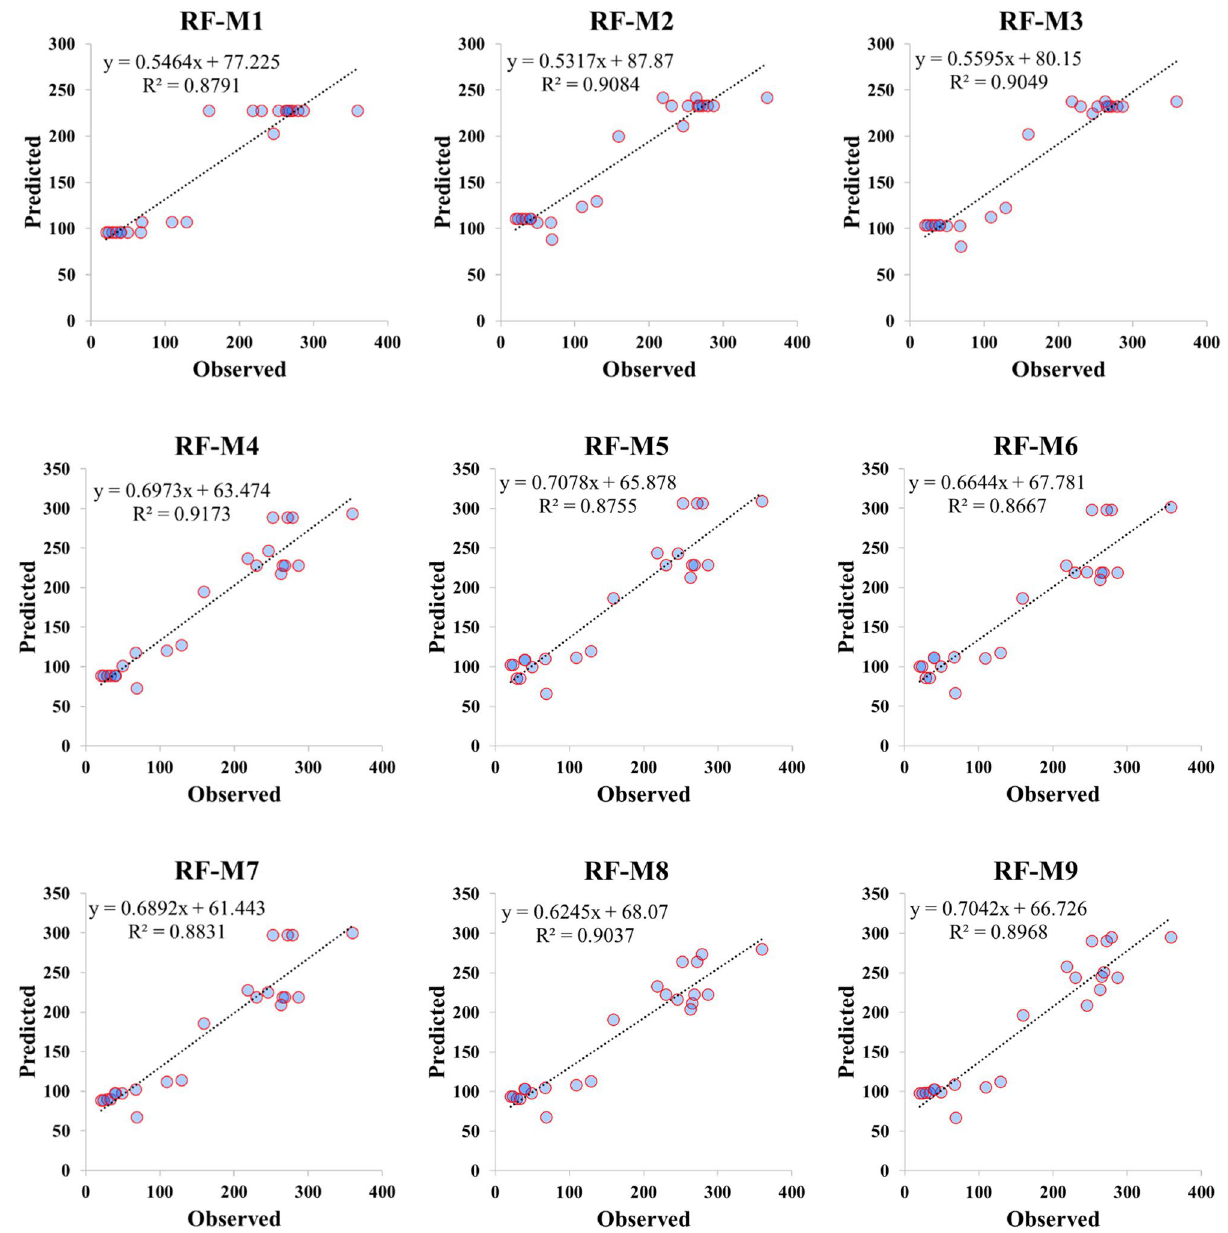
Figure 6. Scatter plot presentation of RF prediction model over the testing modeling